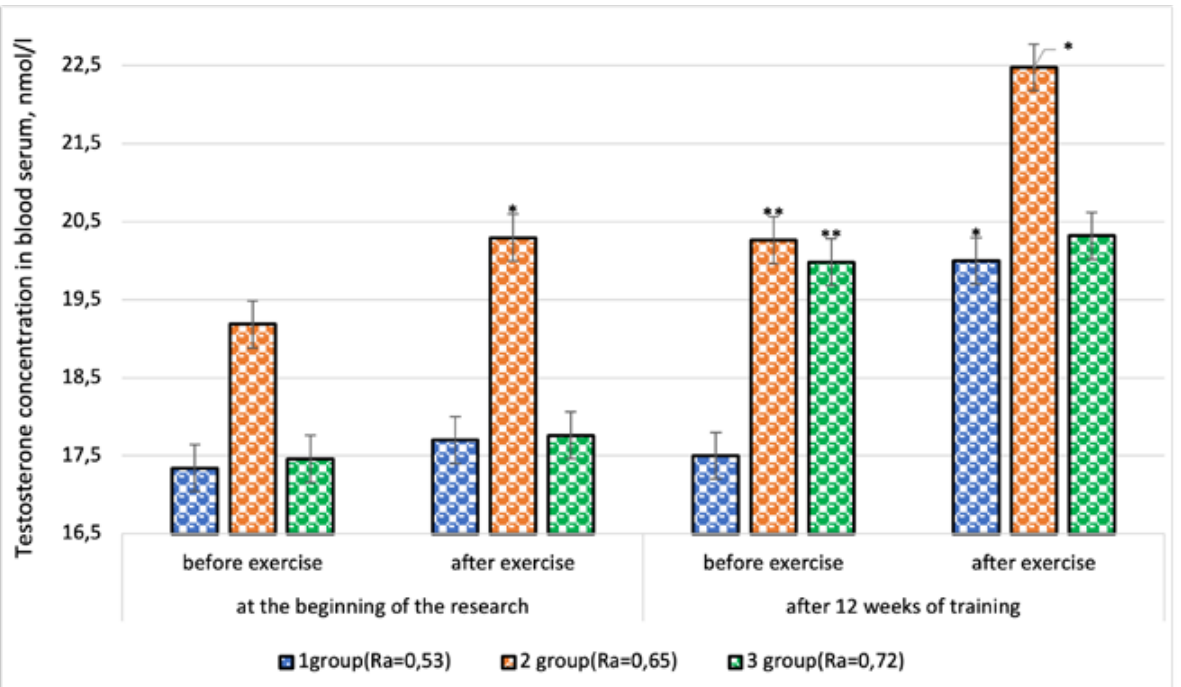
Figure 3. Changes in testosterone concentration in the blood serum of study participants during 12 weeks of training in the conditions of different intensity power load regimes, n=75 Note: * – p<0.05, compared to the indicators before the load; ** – p<0.05, compared to the indicators